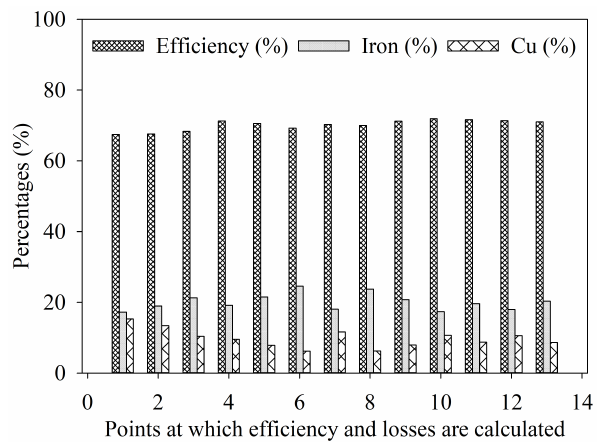
Figure 24. Efficiency at different points taken on Force-Velocity